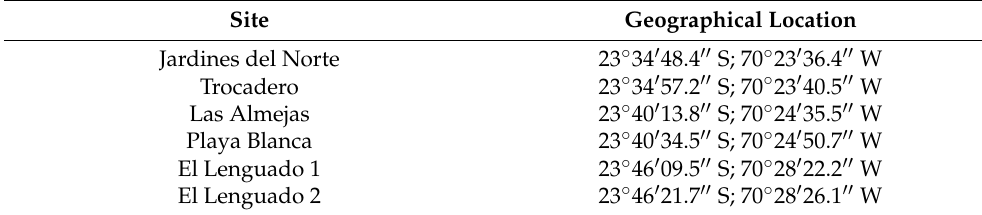
Table 1. Geographical locations of sites included in the present